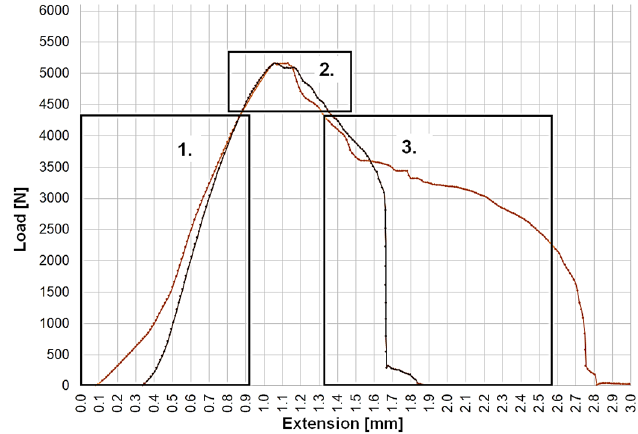
Figure 2. Location of the piece to be tested in the device.